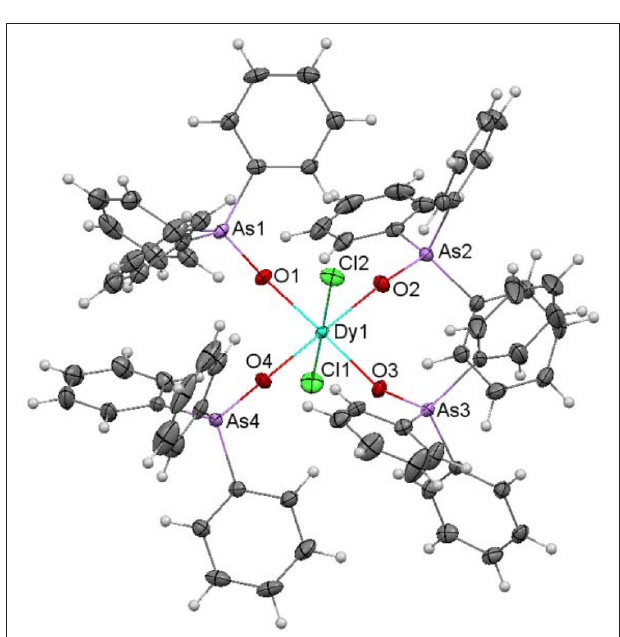
FIGURE 7 | Ellipsoids diagram (50% probability) for [Dy(MePh 2 PO) 4 (OTf) 2 ] + in 6A. Only the Dy, P, and donor O-atoms have been labeled, for clarity. Color code: Dy, light blue; C, gray; F, fluorescent yellow; H, light gray; O, red; P,